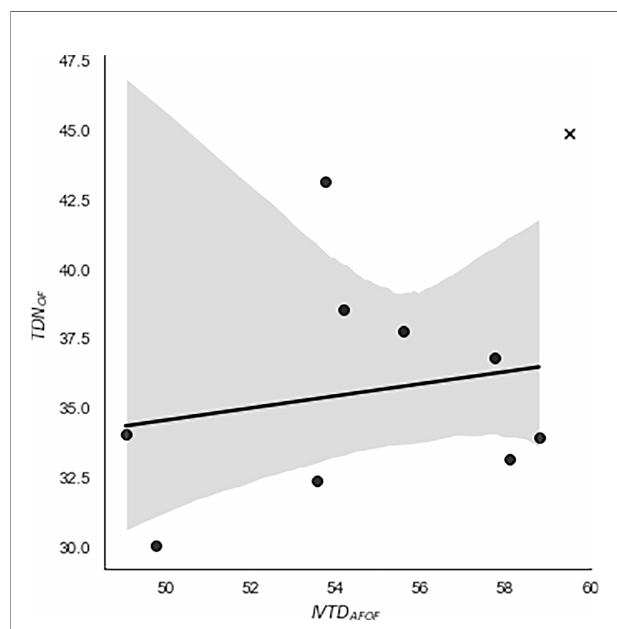
FIGURE 1 | Regression of calculated total digestible nutrients (TDN OF ; non- oil basis) against observed in vitro true digestibility (IVTD AFOF ; ash-free, non-oil basis) of alfalfa cube and 9 cultivars of non-extracted industrial hemp in fl orescence. TDN OF values were calculated using a modi fi ed version of the summative equation system proposed by Weiss et al. (1992). To obtain IVTD AFOF measurements, hemp samples were incubated in an ANKOM Daisy II Incubator for 48 h following the manufacturer ’ s instructions. There was no relationship observed between IVTD AFOF and TDN OF (Adj. R 2 = 0.10), and regression of the two variables resulted in the equation TDN OF = 0.2179 (IVTD AFOF ) + 24.639. Hemp cultivars = (cid:129) . Alfalfa Cube = X.